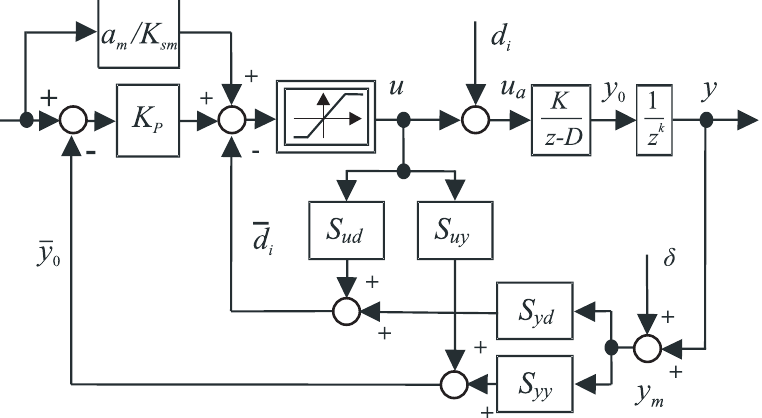
Figure 4. Reconstruction of an input disturbance d i and of an undelayed first-order plant output y 0 from sequences of the input u and the measured delayed output y m ; δ -measurement